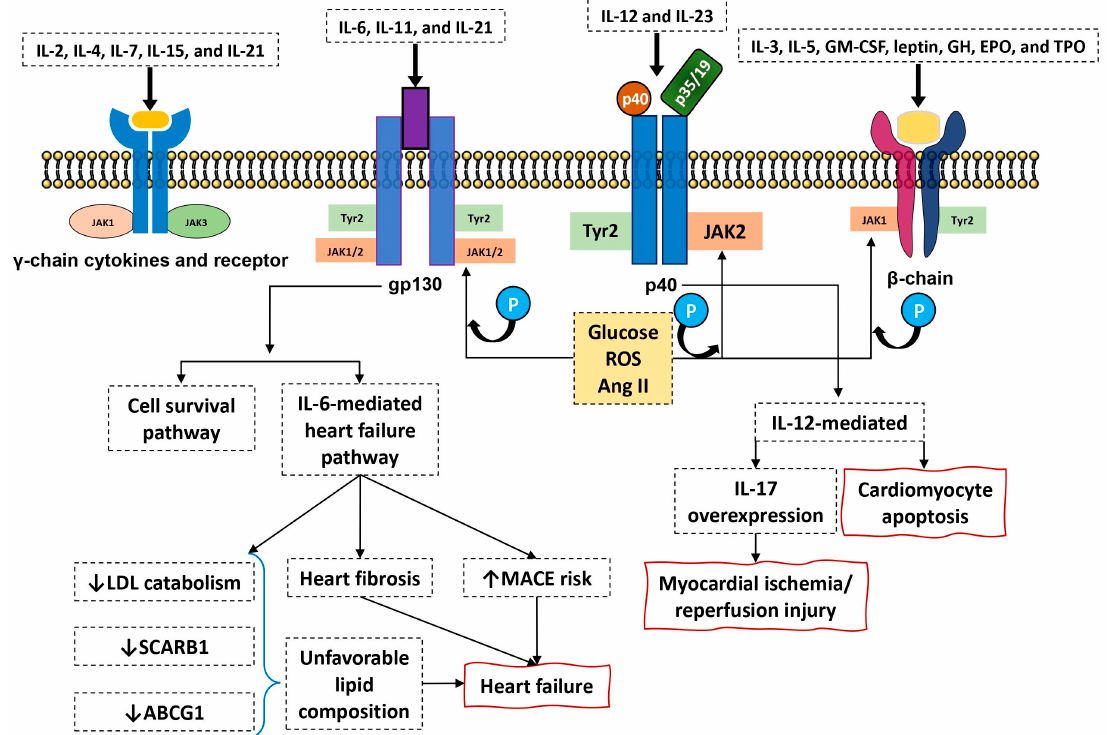
Figure 1. Several cytokine families utilize type I receptors. Receptors with gp130 component transmits signals from IL-6, IL-11, and IL-27 with subsequent activation of JAK1-JAK2 and TYK2 molecules. Cytokines activate (mainly IL-6) heart survival pathway resulting in stabilization of the heart function in ischemia/reperfusion conditions. The same pathway contributes however in deterioration of heart function and increases the risk of major adverse cardiovascular events (MACE), leading to heart fibrosis with subsequent development of heart failure. Cytokines IL-12 and IL-23 that interact with p40 receptor component transmit signals via activation of JAK2 and TYK2 molecules resulting in cardiomyocytes apoptosis. Moreover IL-12 facilitates IL-17 overexpression leading to myocardial/reperfusion injury. Blocking JAK/STAT pathway with